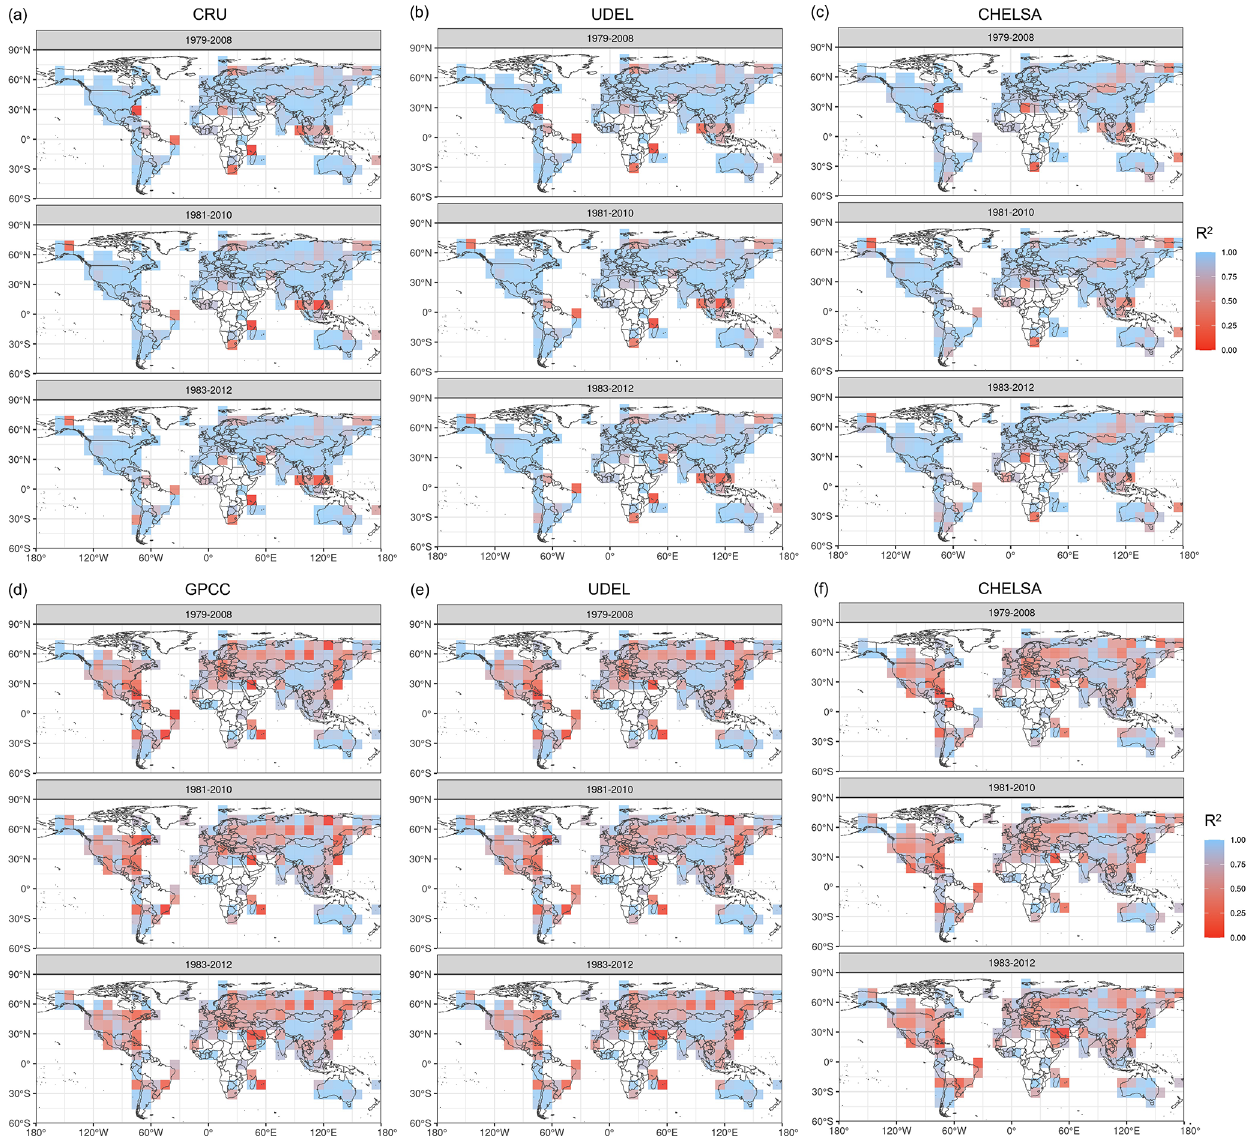
Figure 10. Small-scale comparison of annual temperature (MAT) and mean annual precipitation (MAP) variables derived from different datasets with station data. Small-scale correlation between the 30-year average mean annual temperature (MAT) and mean annual precip- itation (MAP) data and ground observations for three historical periods (1979–2008, 1981–2010, 1983–2012). The station data are from GHCN-D and the GSOD database. The figure shows the R 2 value for 10 ◦ grid cells. Panels (a) , (b) , and (c) are MAT results. Panels (d) , (e) , and (f) are MAP results. (a) MAT is calculated from downscaled monthly temperature data from the CRU dataset, (b) from the UDEL dataset, and (c) from the CHELSA dataset. (d) MAP is calculated from downscaled monthly precipitation data from the GPCC dataset, (e) from the UDEL dataset, and (f) from the CHELSA